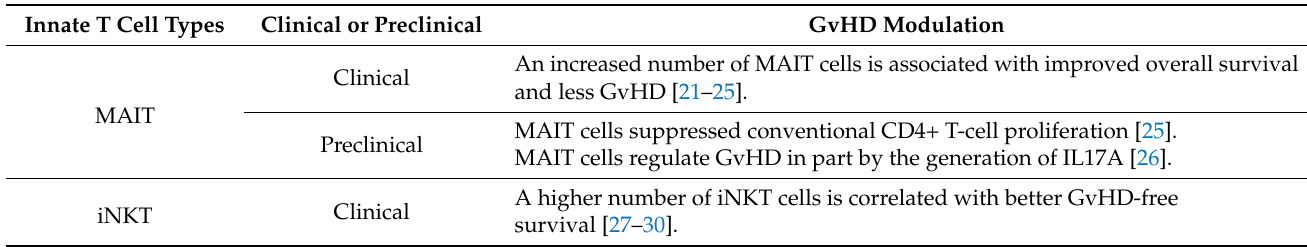
Table 1. GvHD modulation by three innate T cells, including MAIT, iNKT, and γδ T